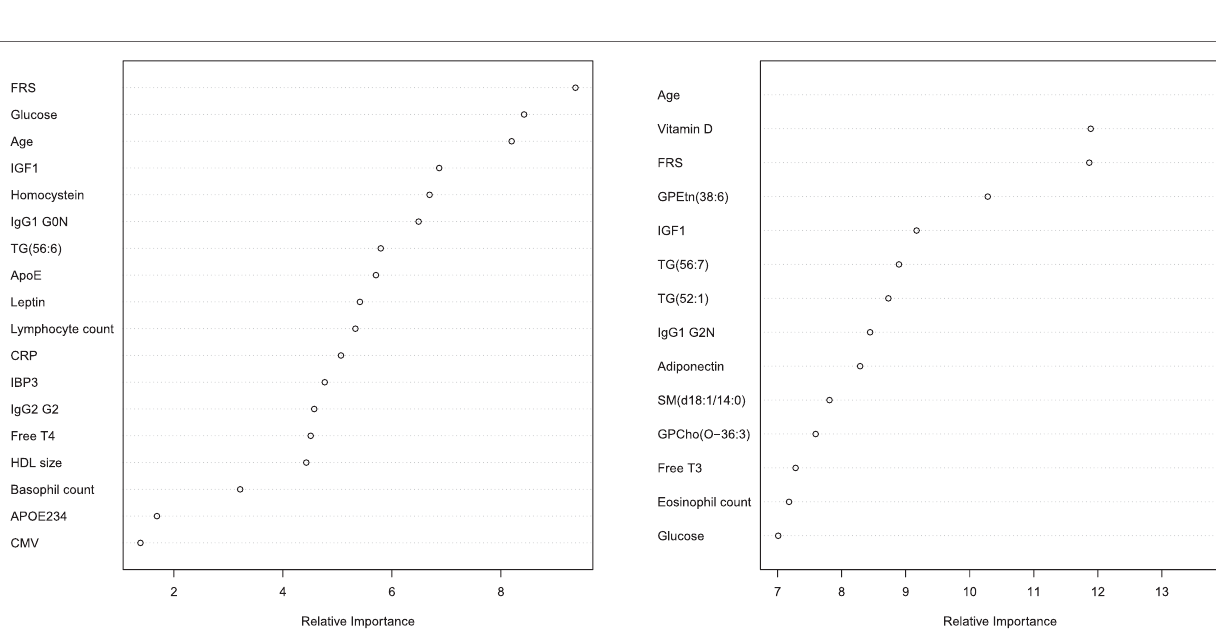
FigUre 2 | relative importance plot in the prediction longevity potential in males (left panel) and females (right panel) in model 3 . The x -axis shows the relative importance, as mean decrease accuracy, and the y -axis shows the traits that have been selected in model 3. The importance plot is a critical output of the random forest algorithm and to assess relative importance of the individual markers in the selected model, the machine learning tool Breiman’s Random Forests 21 was used. The traits on the y -axis ordered top-to-bottom as most- to least-important. Therefore, the most important variables for classification are at the top and an estimate of their importance is given by the position of the dot on the x -axis. Abbreviations left panel: FRS, Framingham risk score; IGF1, insulin-like growth factor 1; IgG1 G0N, immune globulin subclass G1 with Fc N -glycosylation at G0; TG (56:6), triglyceride with 56 carbon atoms and 6 double bonds; ApoE, lipoprotein E plasma levels; CRP, C-reactive protein plasma levels; IBP3, IGF1-binding protein 3; IgG2 G2, immune globulin subclass G2 with Fc N -glycosylation at G2; Free T4, Thyroxine; HDL size, high-density lipoprotein particle size; APOE234, Apolipoprotein isoform; CMV, cytomegalovirus seropositivity. Abbreviations right panel: FRS, Framingham risk score; GPEtn (38:6), ethanolamine glycerophospholipid with 38 carbon atoms and 6 double bonds; IGF1, insulin-like growth factor 1; TG(56:7), triglyceride with 56 carbon atoms and 7 double bonds; TG(52:1), triglyceride with 52 carbon atoms and 1 double bond; IgG1 G2N, immune globulin subclass G2 with Fc N -glycosylation at G2; SM(d18:1/14:0), Sphingomyelin (d18:1/14:0); GPCho(O-36:3), phosphatidylcholine O-36:3; Free T3,